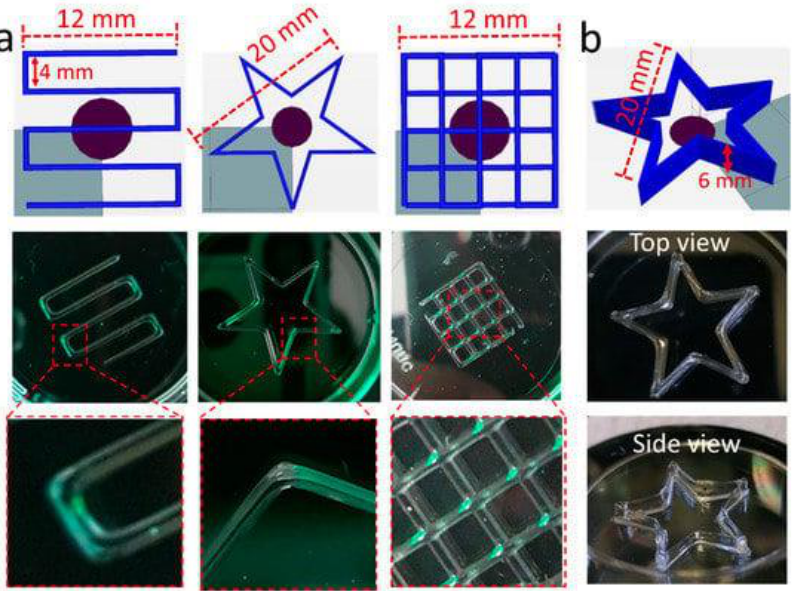
Figure 11. ( a ) The 3D printability of 25 wt.% pPrOzi 100 - b -pEtOx 100 based hydrogel with various forms such as serpentine line, a star, and a double layer grid (pressure; 90 kPa, speed 2 mm/s) (left to right). ( b ) The 3D printability of 25 wt.% pPrOzi 100 - b -pEtOx 100 based hydrogel with 1 wt.% Laponite XLG (12 layered star) (pressure; 120 kPa, speed 1 mm/s) [207].